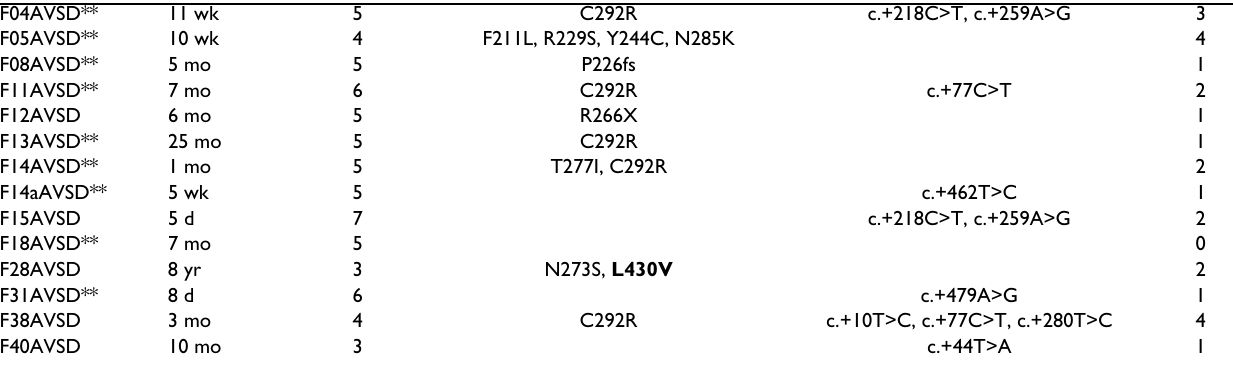
Table 3: Spectrum of GATA4 mutations (nonsynonymous and 3'-UTR) in diseased tissues of malformed hearts